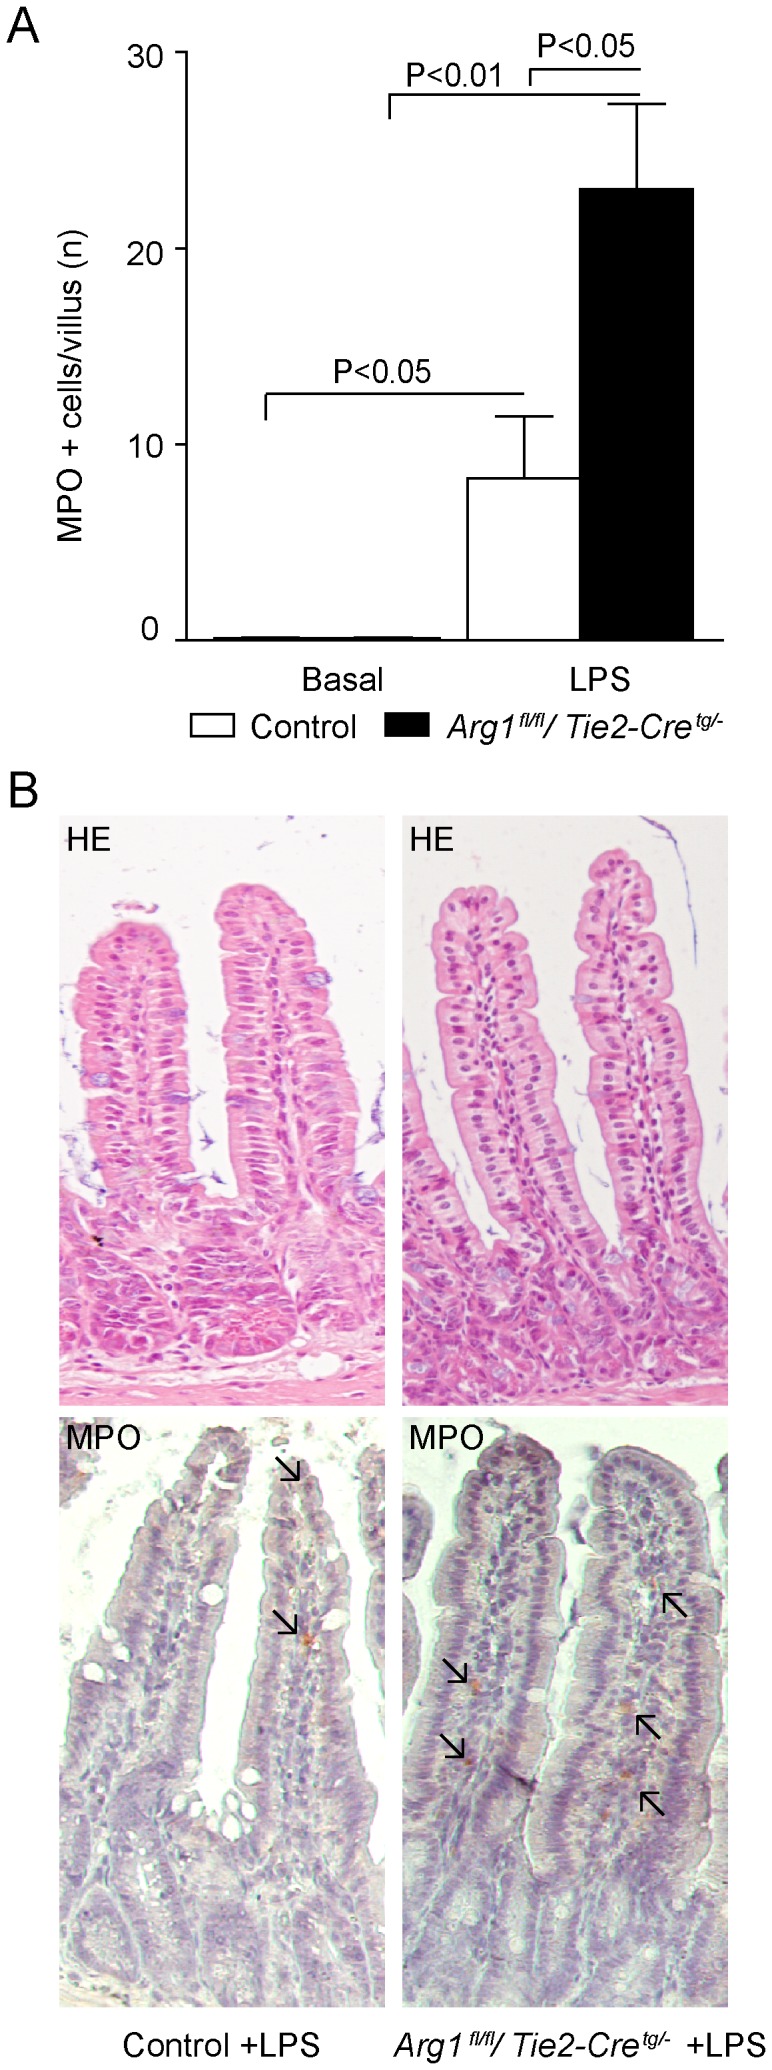
LPS treatment increases density of MPO-positive cells in Arg1fl/fl/Tie2-Cretg/− mice.(A) LPS infusion increased the influx of MPO-positive cells into jejunal tissue of control and Arg1fl/fl/Tie2-Cretg/− mice, but more so in Arg1fl/fl/Tie2-Cretg/− mice (P<0.05). Magnification 200x. (B) Jejunal villi of H&E- (upper panel) and MPO-stained (lower panel) villi of LPS-treated control (left) and Arg1fl/fl/Tie2-Cretg/− mice (right). Arrows indicate the MPO positive cells. Magnification 200x.